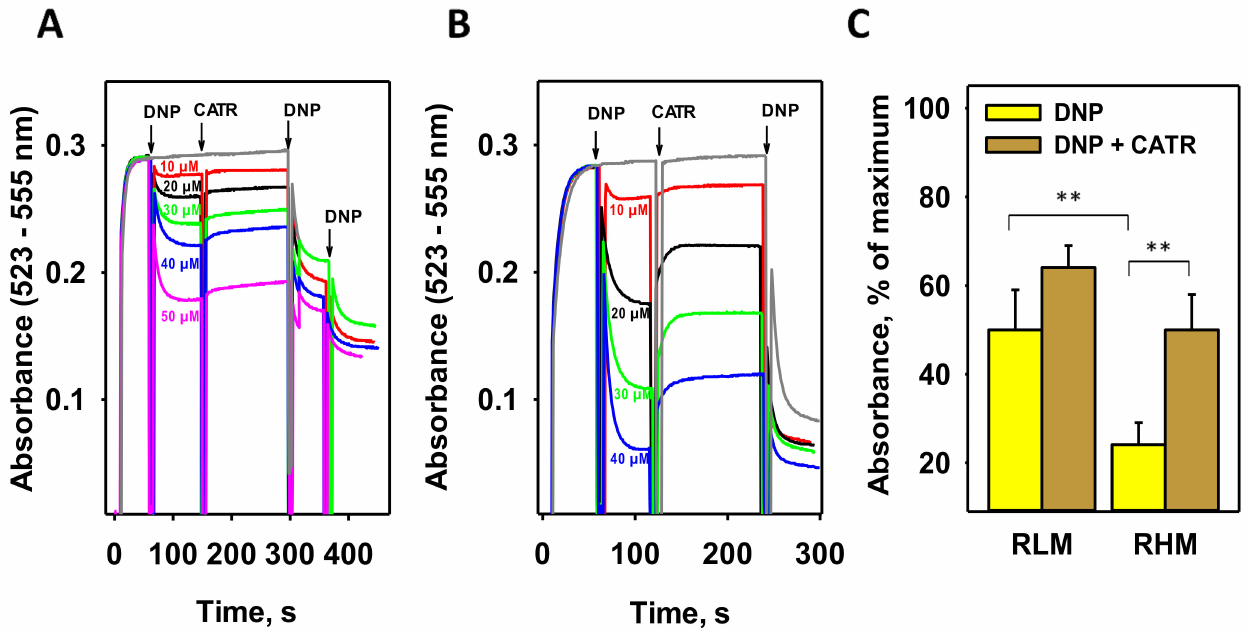
Figure 1. CATR recovers the DNP-mediated decrease in mitochondrial membrane potential (MMP) in isolated rat mitochon- dria. Representative recordings of MMP in rat liver mitochondria ( A ) and heart ( B ) mitochondria correspond to changes in the absorbance of the potential-sensitive dye safranin O (15 µ M). CATR was added at a final concentration of 3 µ M; the concentration of DNP (unless otherwise indicated) was 50 µ M. The gray line represents the control measurement without the addition of CATR or DNP. ( C ) Quantification of MMP recovery by CATR (brown) in the presence of 30 µ M DNP (yellow, brown). Data are the mean ± SD of at least three independent experiments; ** p < 0.01. For other conditions, see Section 2 (Materials and